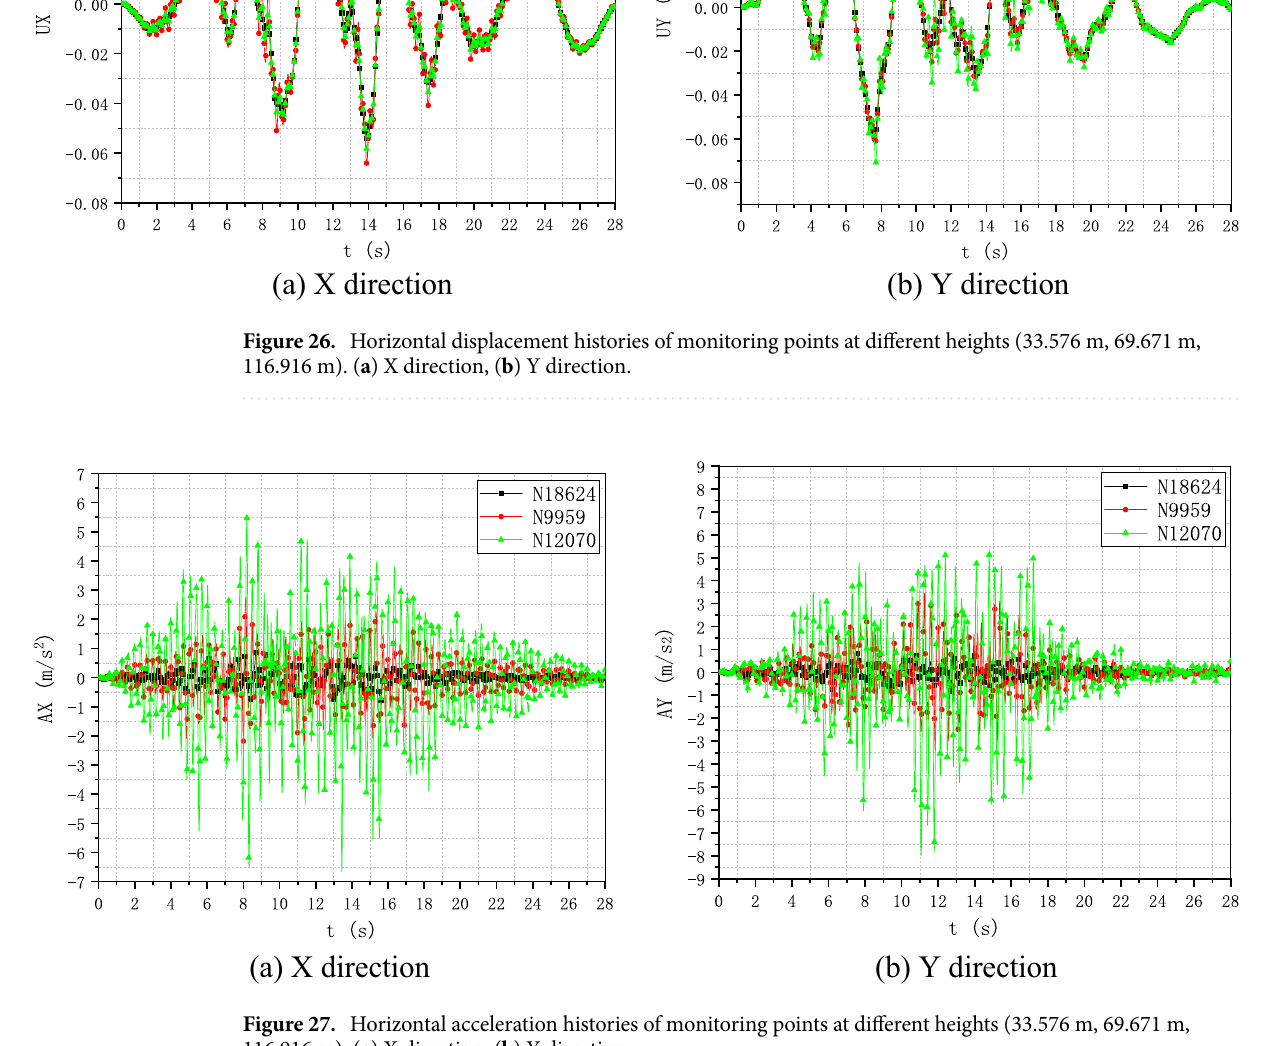
Figure 27. Horizontal acceleration histories of monitoring points at different heights (33.576 m, 69.671 m, 116.916 m). ( a ) X direction, ( b ) Y